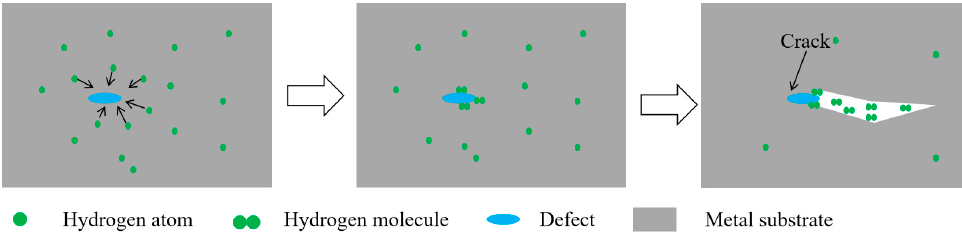
Figure 8. Schematic diagram of hydrogen embrittlement.